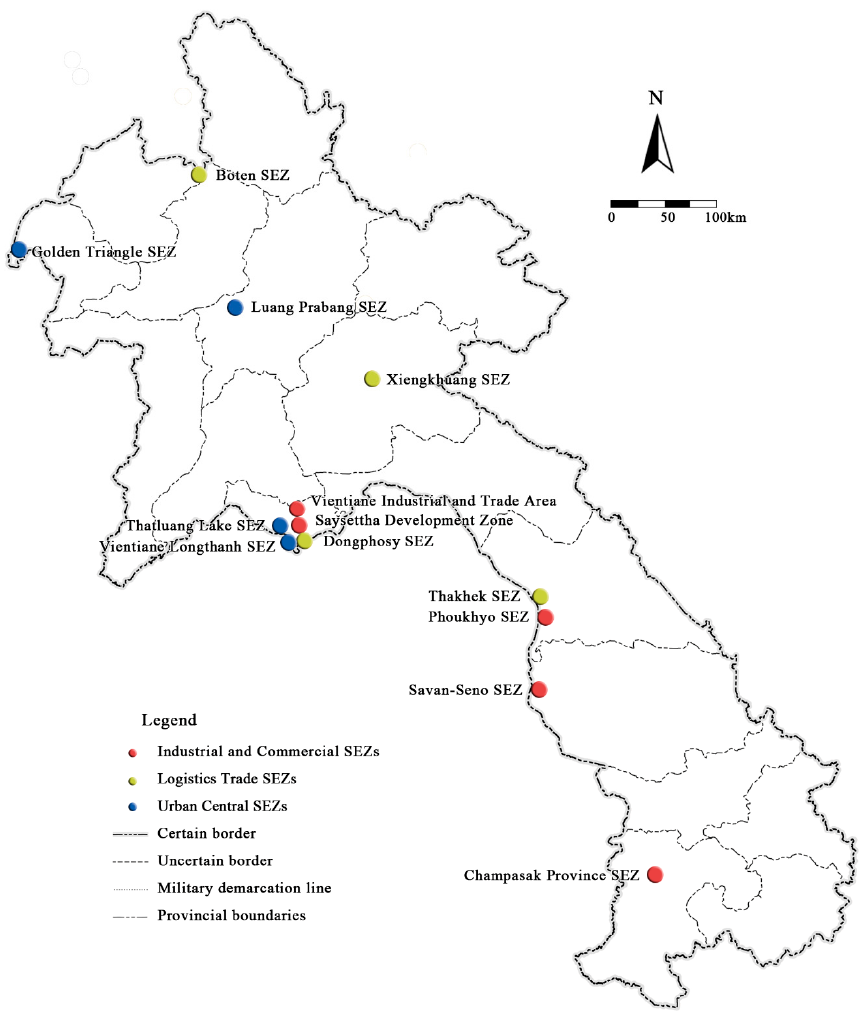
Figure 2. Spatial distribution of the SEZs in Laos.